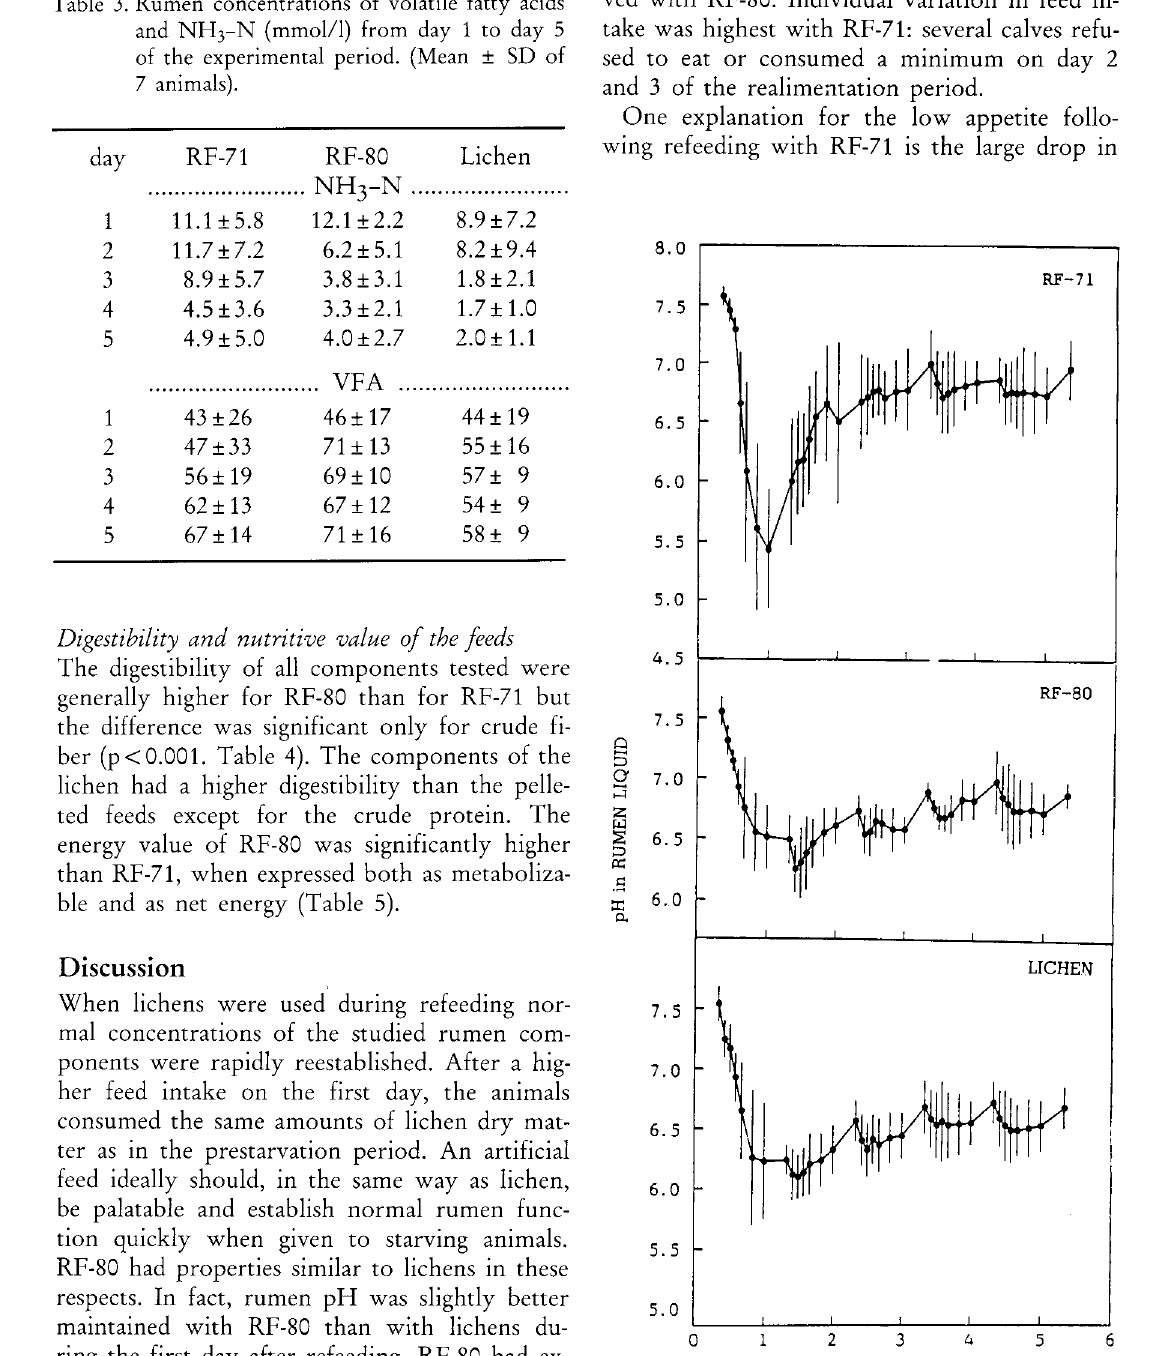
Fig. 4. Changes in pH of rumen fluid in 7 reindeer calves given ad. lib. access to either lichen, RF-71 or RF-80 after 3 days of restricted feed ing and 2 days of complete starvation. Avera ges and standard